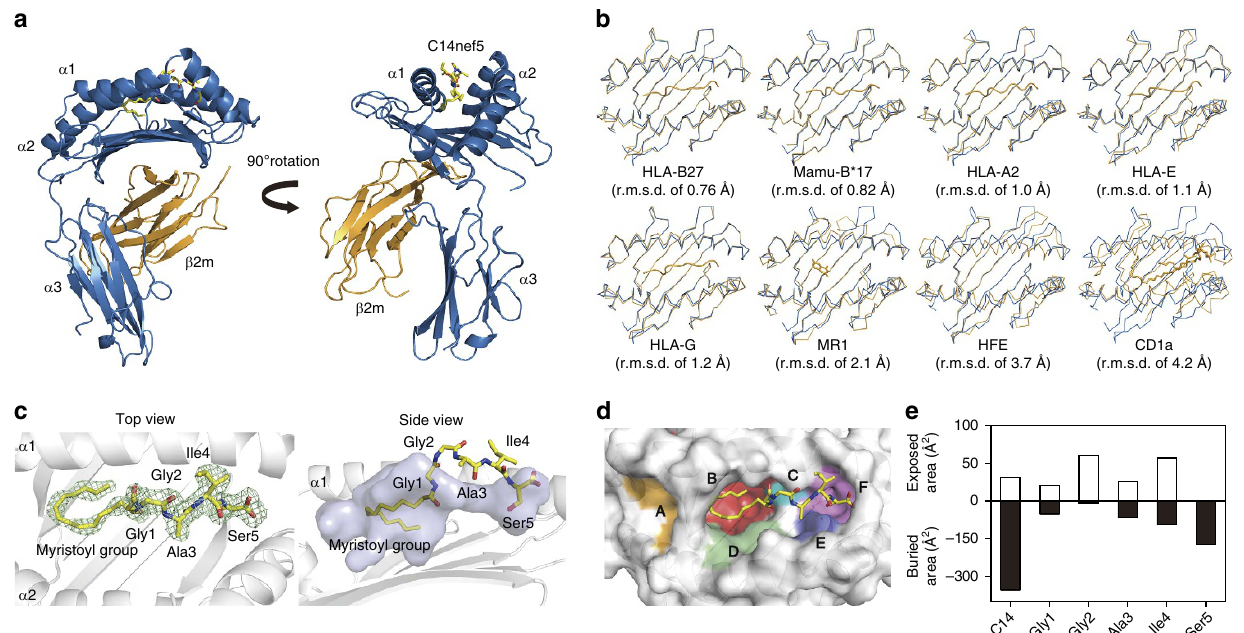
Figure 2 | The overall structure of the Mamu-B*098 complex. ( a ) Two views of the trimer complex of the ectodomain of Mamu-B*098 heavy chains (blue), b 2m (orange) and C14nef5 (yellow) are shown. ( b ) Superimposed images of the a 1 and a 2 domains of Mamu-B*098 (blue) with those of MHC class I and MHC class I-like molecules (orange) are shown. ( c ) C14nef5 binding to Mamu-B*098 is demonstrated by a 2Fo-Fc map (green mesh) contoured at 0.8 s (left). The bound lipopeptide accommodated in the semi-transparent Ag-binding cavity is shown (right). ( d ) The surface of the Ag-binding groove with pockets A through F is shown. ( e ) Solvent accessible surfaces of C14nef5 captured by Mamu-B*098 are shown for the myristoyl group and each of the amino acid residues. Filled and unfilled bars indicate buried and exposed areas,